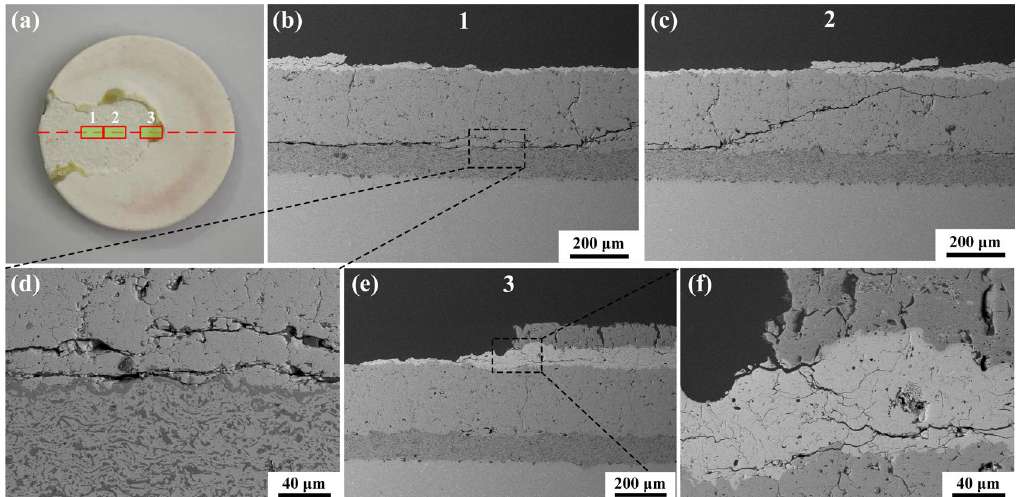
Figure 14. ( a ) Macroscopic and ( b – f ) cross-sectional morphologies of AGAP-GZ/YSZ-YSZ coating after thermal shock test.